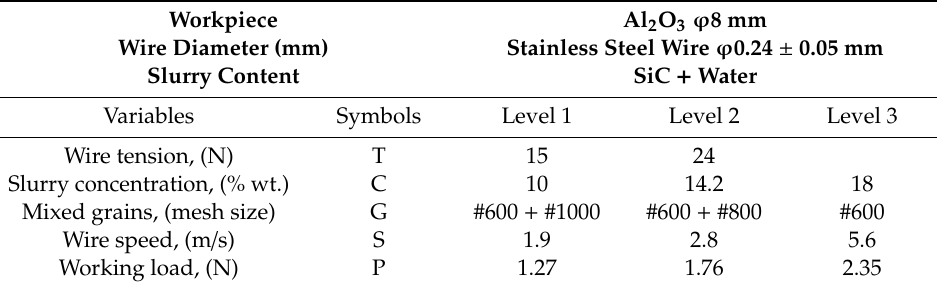
Table 2. Settings for variables and levels in the experiment.